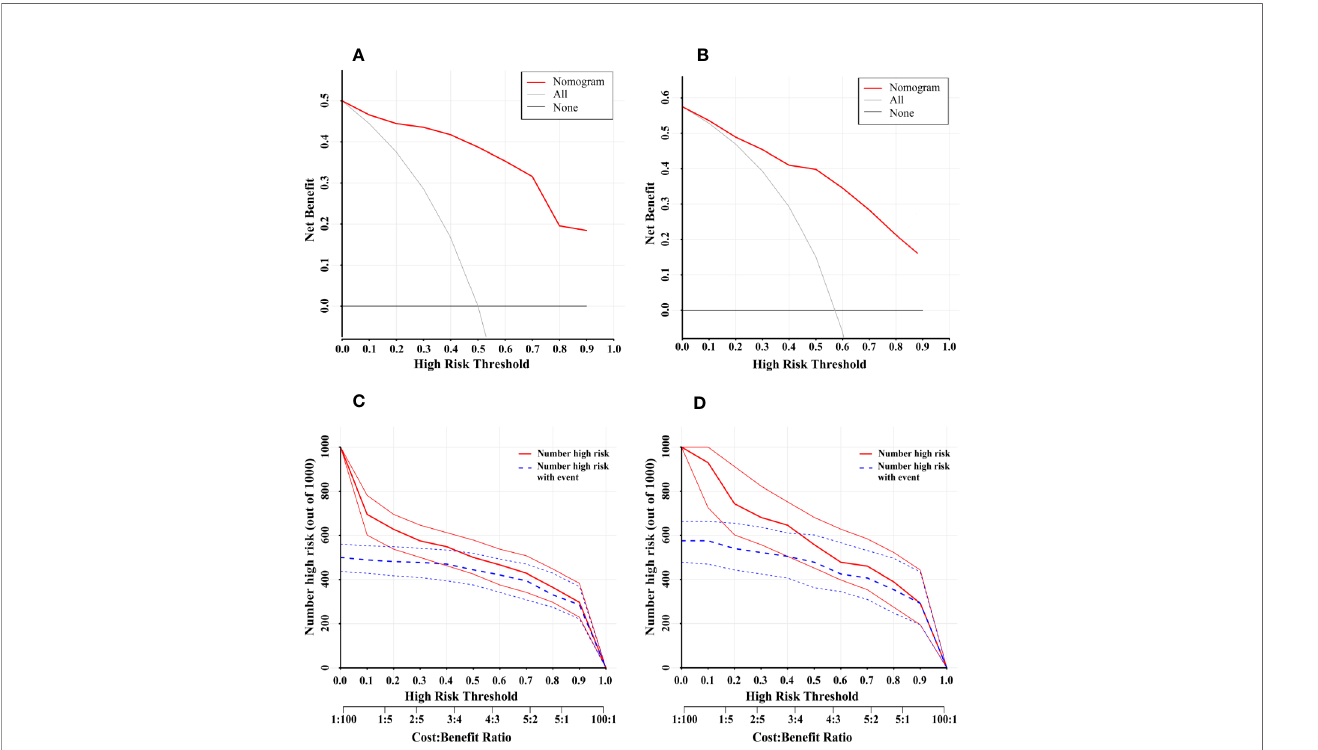
FIGURE 7 | Decision Curve Analysis (DCA) for the nomogram in the training cohort and validation cohort (A, B) . The Y -axis showed the net bene fi t. The X -axis represented the threshold probability. The None-line (black line) represented the net bene fi t when none of the participants were considered to have MVI. The All-line (light gray line) represented the net bene fi t when all participants were considered to have MVI. The red line represented the net bene fi t of the nomogram at different threshold probabilities. The area between the “ None-line ” (black line) and “ All-line ” (light gray line) in the model curve indicated the clinical utility of the model. Clinical Impact Curve (CIA) of the nomogram for predicting presence of MVI in the training cohort (C) and validation cohort (D) . At different threshold probabilities within a given population, the number of high-risk patients and the number of high-risk patients with MVI were